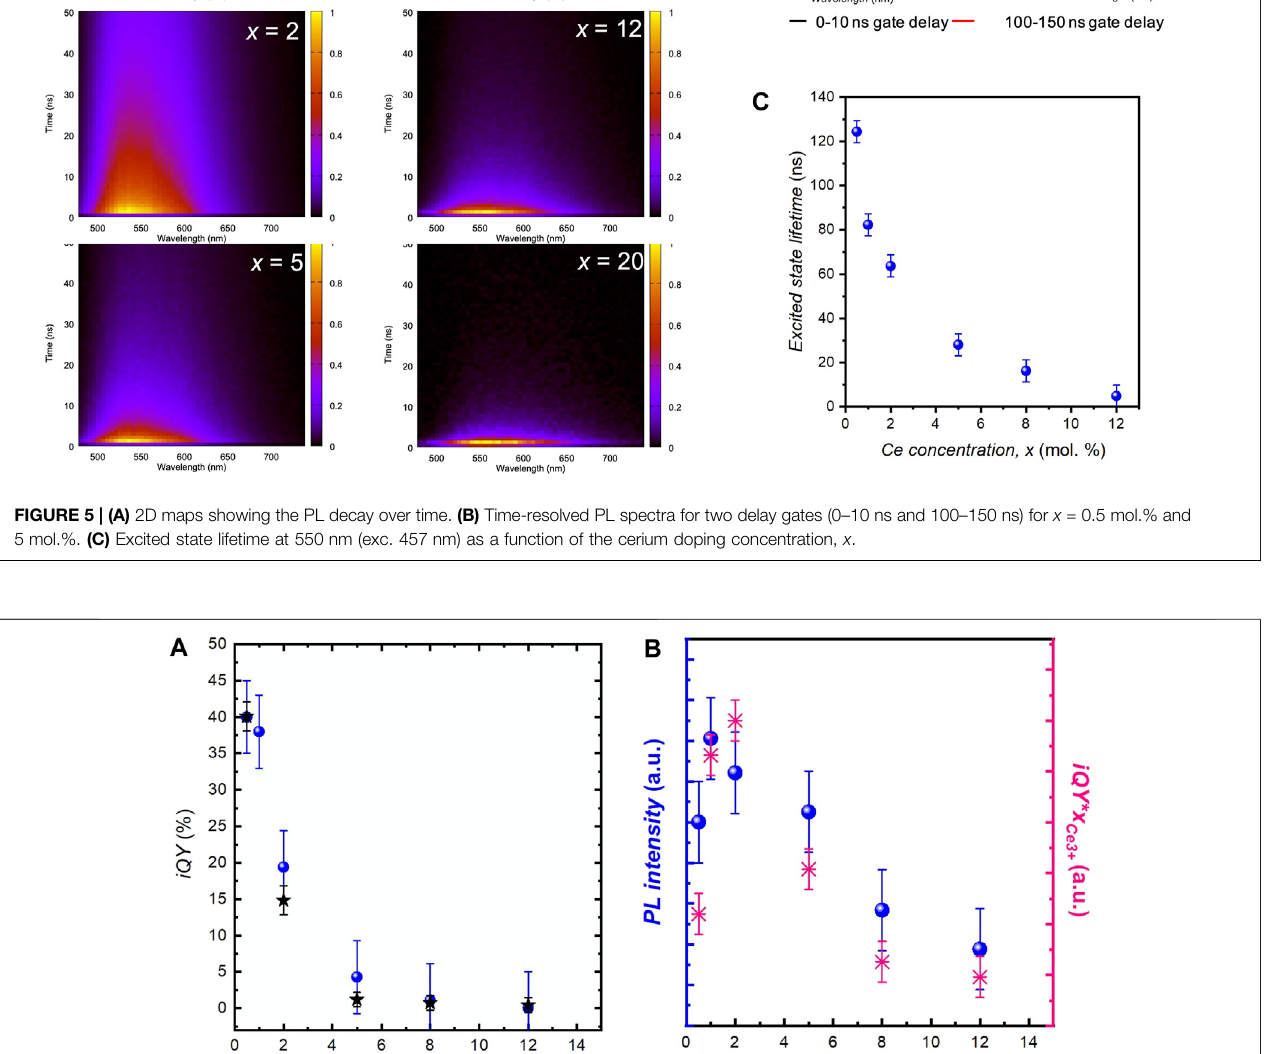
Frontiers in Materials |